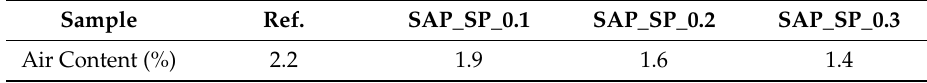
Table 2. Air content of fresh